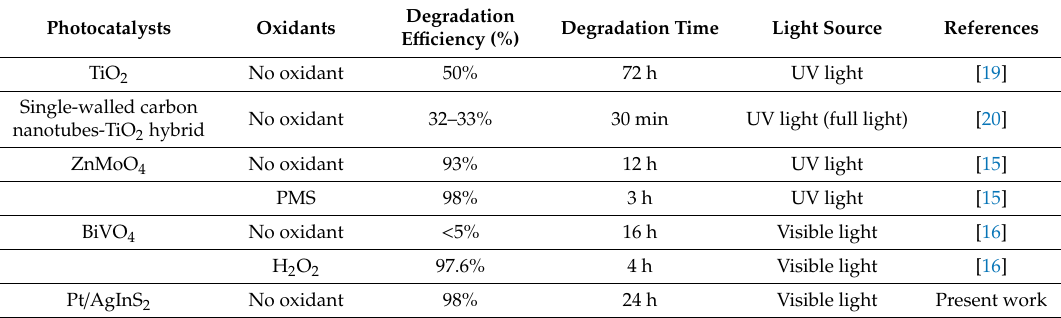
Table 1. Comparison of photocatalytic activity of some photocatalysts with the present photocatalyst for the degradation of